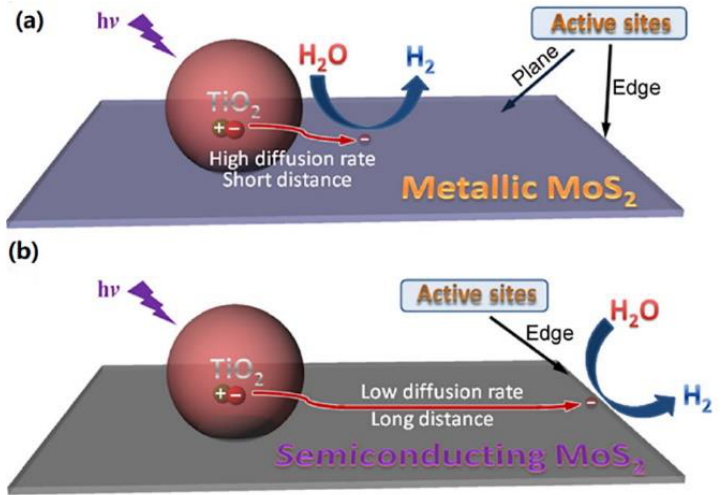
Figure 18. Schematic illustrating charge-transfer behavior and H 2 evolution active sites for ( a ) 1T-MoS 2 /TiO 2 and ( b ) 2H-MoS 2 /TiO 2 . Reprinted with permission from [125]. Copyright 2014, Springer.